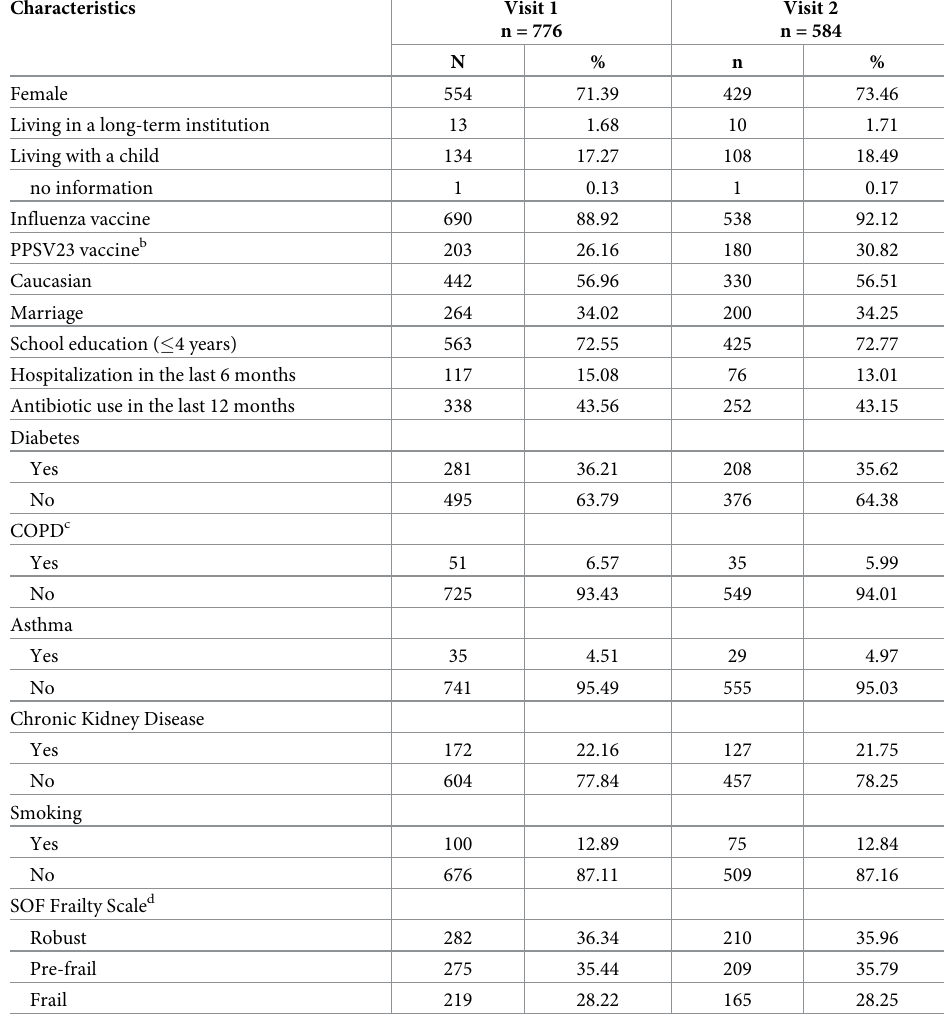
Table 1. Demographic and clinical characteristics of elderly participants in both visit 1 and the follow-up visit (visit 2) a .